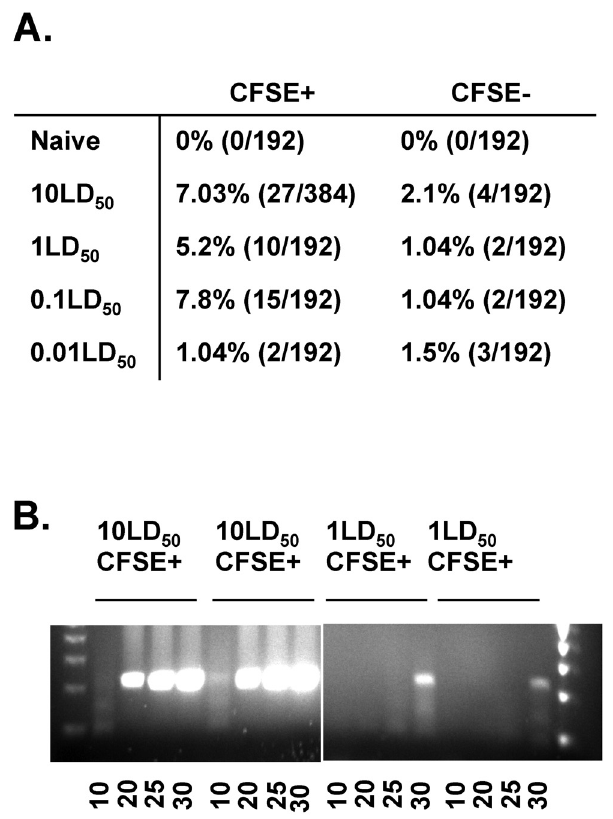
Figure 2. Single cell RT-PCR following increasing inoculum doses. BALB/c mice were treated i.n. with CFSE. 6 hours later, groups of mice (20 mice/group) were left uninfected (Naı¨ve) or infected with the indicated dose of IAV. At 18 hours p.i., draining LN (20 mice/group) were pooled and migratory rDC (CFSE + CD11c + MHC II + ) and LNDC (CFSE neg CD11c + MHC II + ) were single-cell FACS sorted into 96 well plates and analyzed by single-cell RT-PCR for expression of viral NS-2 mRNA as described in Materials and Methods. (A) Data represent the frequency of NS-2 IAV mRNA + cells/total cells analyzed. (B) cDNA from positive samples in (A) was again amplified by nested PCR for NS2. Indicated is the cycle at which the PCR reaction was stopped during the second nested PCR reaction (i.e. the amplification with the NS2C:NS3